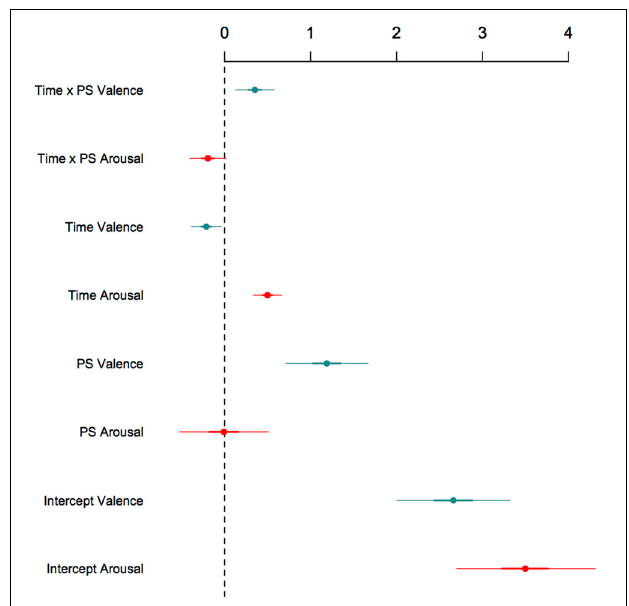
FIGURE 4 | This figure shows regression coefficients for effects modeled as fixed. Estimates are given on the latent scale. To recover coefficients on the data scale, add 1. Time effects were centered at 0. We coded fire-walkers as 0 and passengers as 1. Hence, the intercepts denote the expected arousal and valence for fire-walkers at the middle point of the ritual (on the latent scale). Our interest was in the role × time interaction, which shows a pattern of diverging mean valence for role over time. As indicated here, fire-walkers were found to be increasingly negative in their valence whereas passengers were found to be increasingly positive. These findings are consistent with the predictions of the rite-of-passage